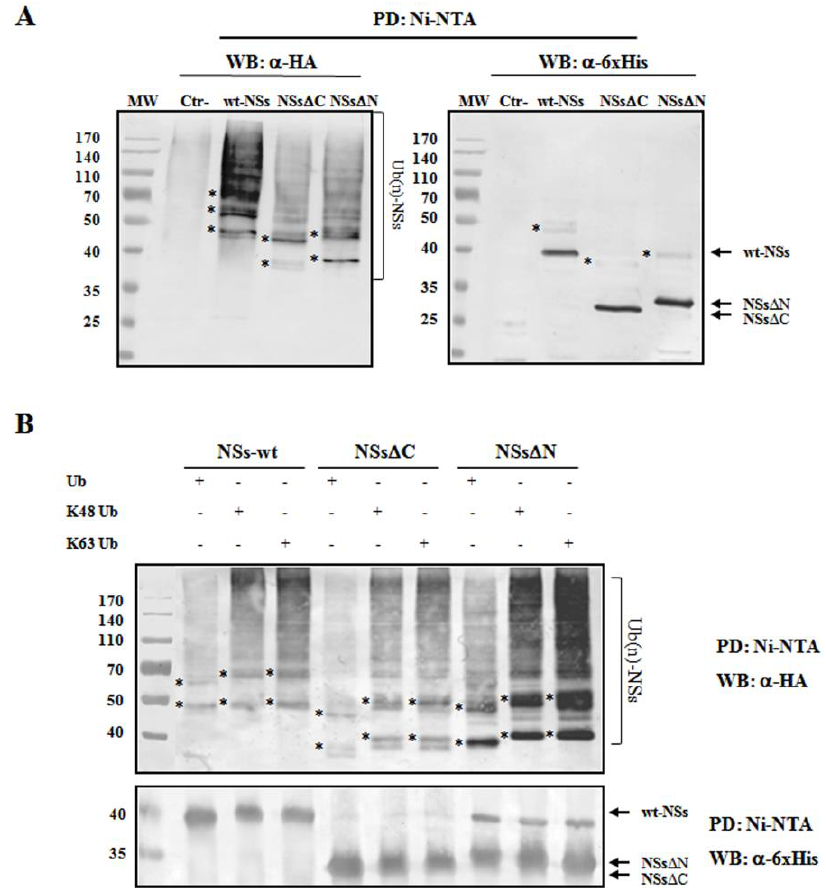
Figure 4. TOSV NSs undergoes ubiquitination. NSs ubiquitination was evaluated by immunoblotting. ( A ) Lenti-X 293T cells were transfected with wt-, ∆ C-, or ∆ N-expressing plasmids, along with the plasmid expressing HA-tagged wild-type ubiquitin (Ub). Cells treated with the proteasome inhibitor MG-132 were collected at 48 h post-transfection and NSs protein enrichment was performed on cell lysates by pull-down (PD) experiments using Ni-NTA agarose beads. 6 × His-NSs-enriched samples were subjected to immunoblotting for Ub ( α -HA) or NSs ( α -6 × His) detection. The ubiquitinated status of the three NSs forms was evaluated as a modification of the targeted substrate, causing a shift in MW of ~10 kDa (mono-ubiquitination) or multiples. Asterisk represents ubiquitinated NSs forms. ( B ) The rate on K 48 -and K 63 -moiety ubiquitination was assessed by PD assay and immunoblotting. Lenti-X 293T cells were transfected with wt-, ∆ C, or ∆ N NSs expressing plasmids, along with the plasmid expressing HA-tagged K 48 -only or K 63 -only ubiquitin mutants. Twenty-four hours later, cells were treated with MG-132 and collected after additional 24 h. Lysates were prepared and PD with Ni-NTA agarose beads. Isolated proteins were separated by SDS-PAGE and probed by immunoblotting for NSs ( α -6 × His) and Ub-K 48 and Ub-K 63 ( α -HA) detection. Asterisk indicates ubiquitinated forms of the NSs proteins.